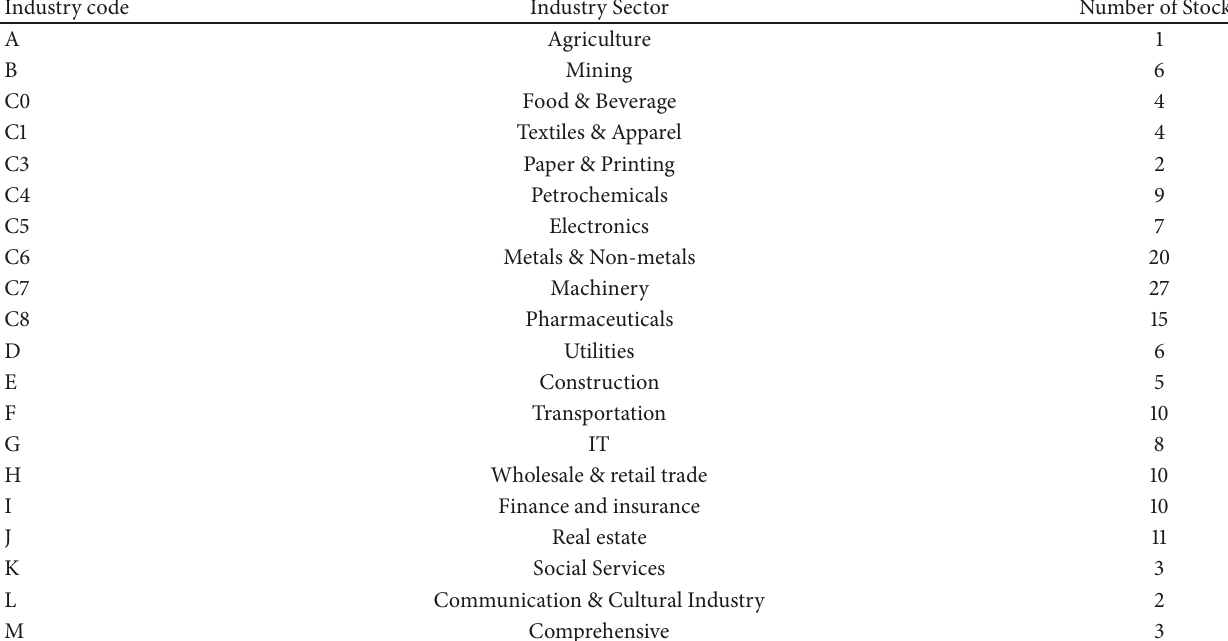
Table1:163componentstocksofCSI300areincludedinourdataset.Inthistable,welisttheChinaSecuritiesRegulatoryCommission(CSRC)